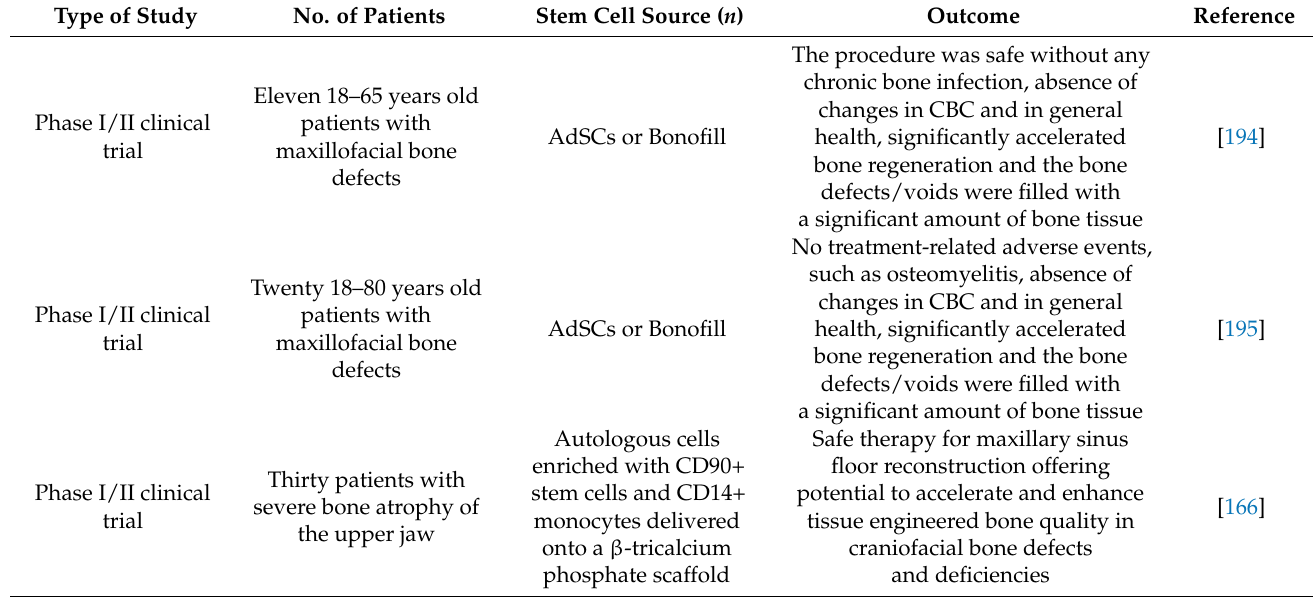
Table 8. Undertaken clinical trials in treatment of craniofacial defects and diseases using MSCs. Type of